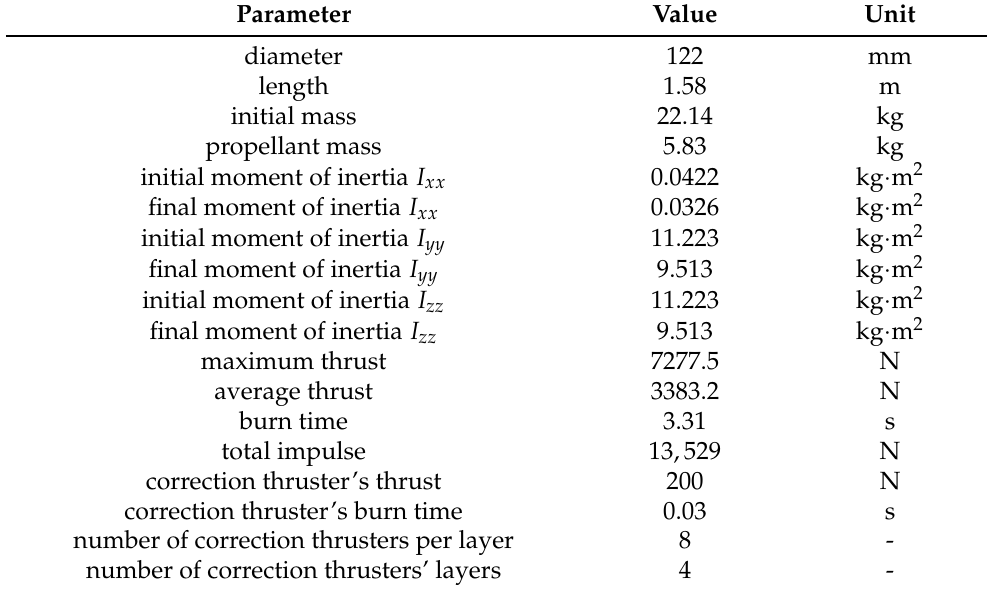
Table 1. Generic rocket’s